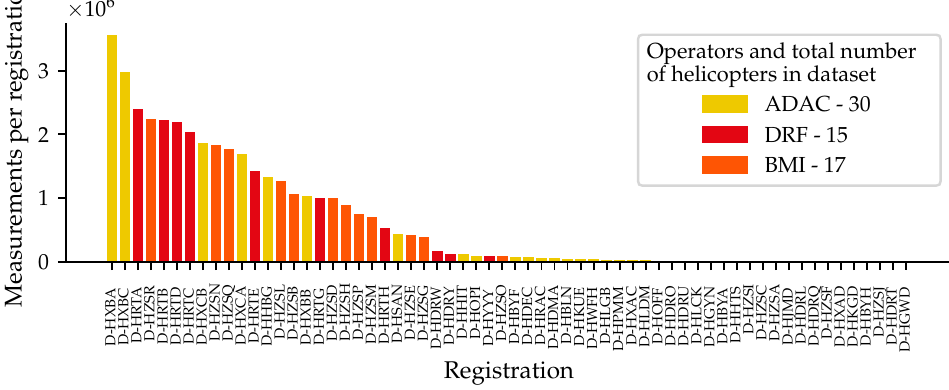
Figure 7. Number of measurements of each registration within the data set. A total of 62 EC135 helicopter registrations are included in the filtered data set. Figure 7 360 shows the measurements per helicopter registration – the top 20 helicopters account for 361 approximately 92 % of all measurements. All operators are represented in the data, which 362 may help in exploring differences between them.